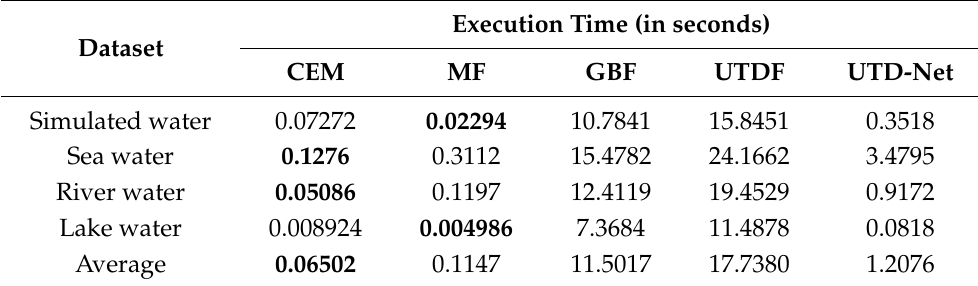
Table 7. Average execution time (in seconds) of the compared methods for all the